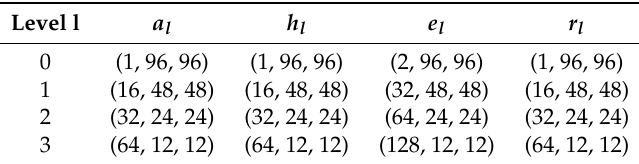
Table 1. PredNet tensors: size of the tensors for the different levels of the PredNet architecture expressed as (channels, width,